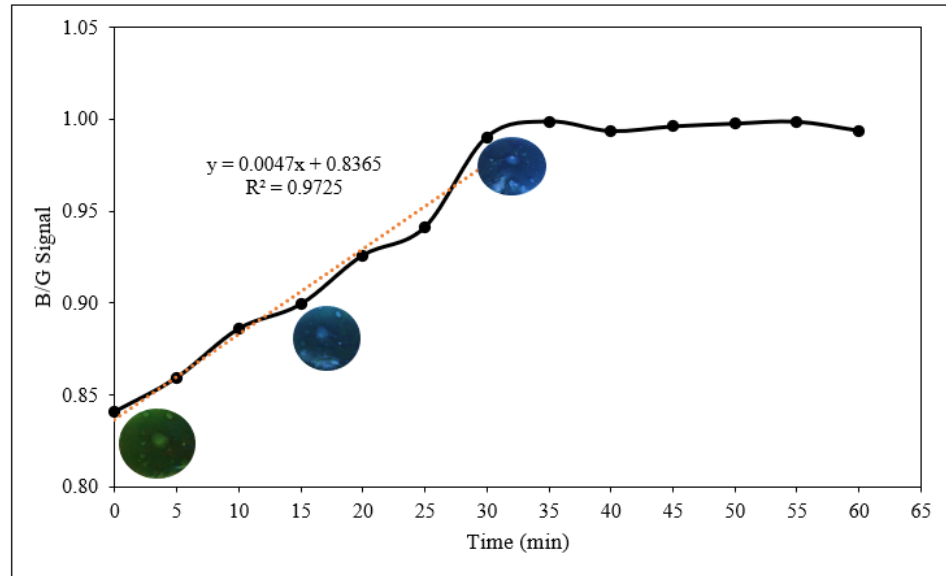
Figure 8. The response time of starch/PANI 0.4% film towards 600 ppm ammonia solution. The B/G signal increased from 0.84 to 1.00 in the first 30 min and achieved